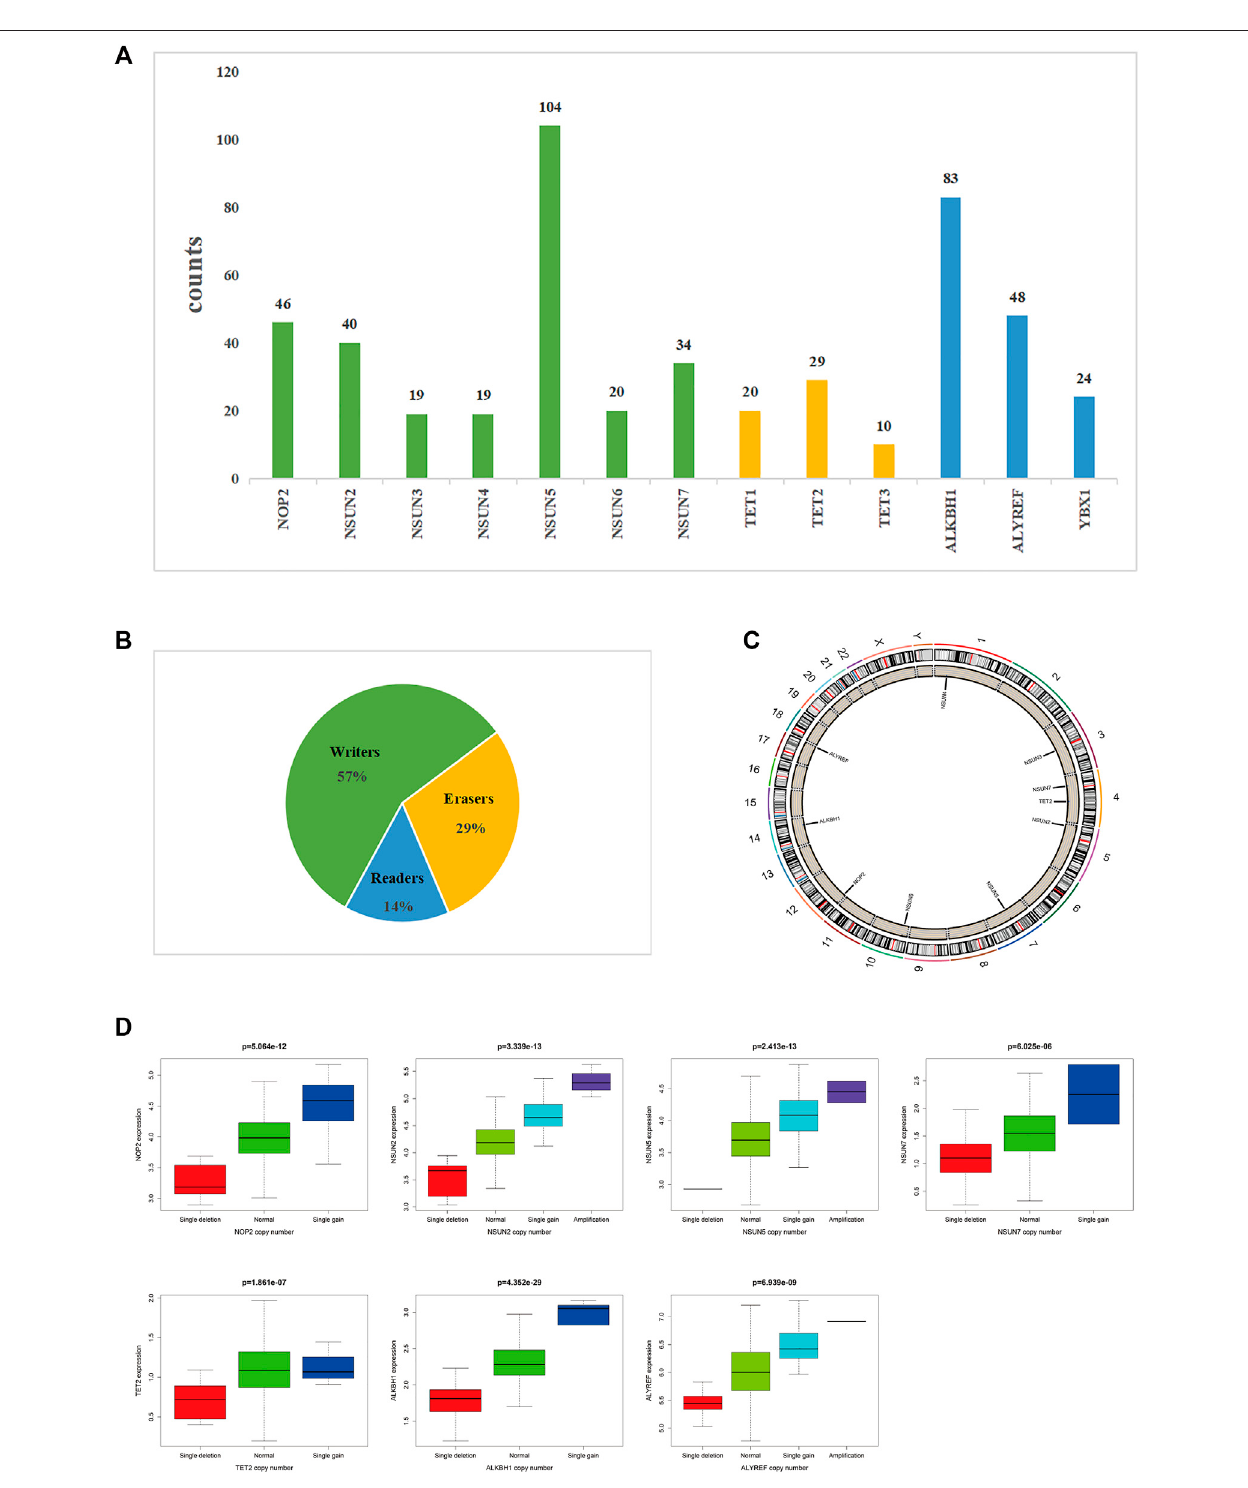
FIGURE 4 | The landscape of CNV of m 5 C-related regulators in COAD. (A,B) Frequency of CNV of 13 m 5 C-related regulators in COAD. (B) Percentage of CNV of 13 m 5 C-relatedregulatorsinCOAD. (C) LocationofCNValterationof13 m 5 C-relatedregulatorsonchromosomes. (D) NOP2,NSUN2,NSUN5,NSUN7,TET2,ALKBH, and ALYREF displayed a signi fi cant difference in expression due to CNVs.